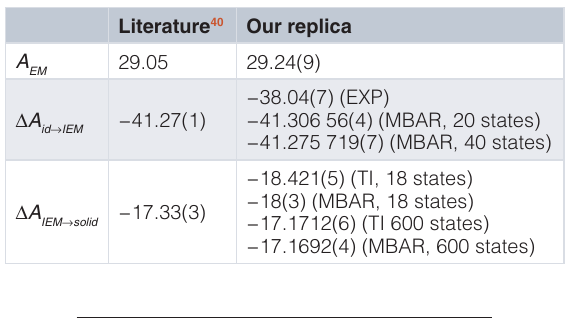
Table 2. Absolute free energy components for polymorph I of acetylsalicylic acid (ASA) at 298.15 K, in k T . B